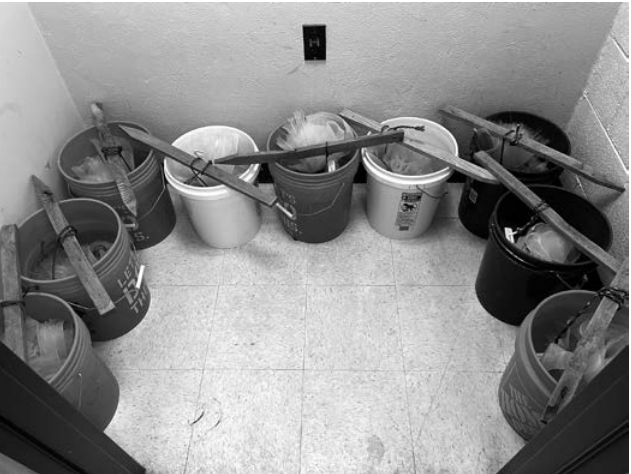
Fig. 1. Photograph showing how the screenwashing setup can be arranged in a small space. Each bucket contains the nested nylon bags holding the matrix and cinched shut with a nylon rope. The rope is then looped around a wooden brace to prevent the bags from sitting on the bottom of the buck- et. The braces are also useful for pulling the bags in and out of the water for agitation before drying. The set up for screenwashing with paint sieves (not pictured) is the same, including the use of the braces.